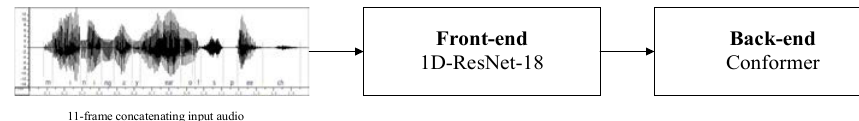
Fig. 1. Conformer model architecture.